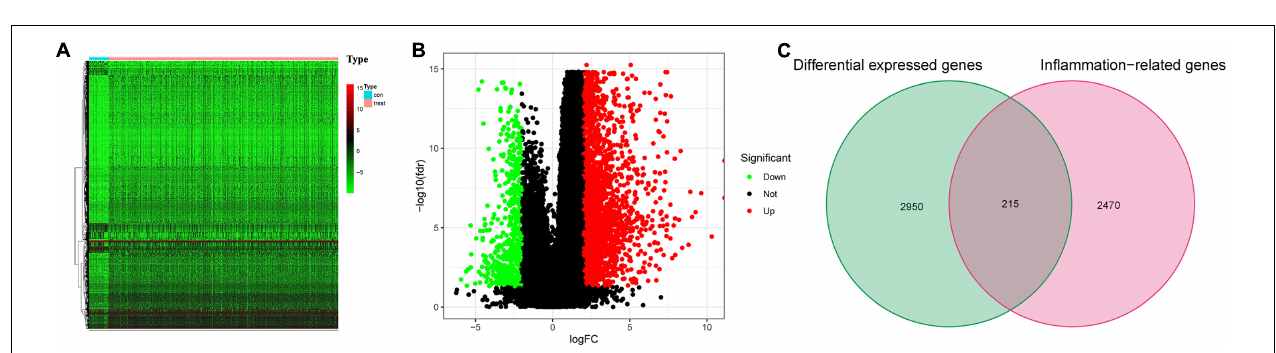
FIGURE 2 | Differentially expressed inflammation-related genes. (A) The heatmap for differential expressed genes between normal and patients with gastric cancer (GC). (B) Volcano plot. (C) Venn diagram to identify differentially expressed inflammation-related genes.